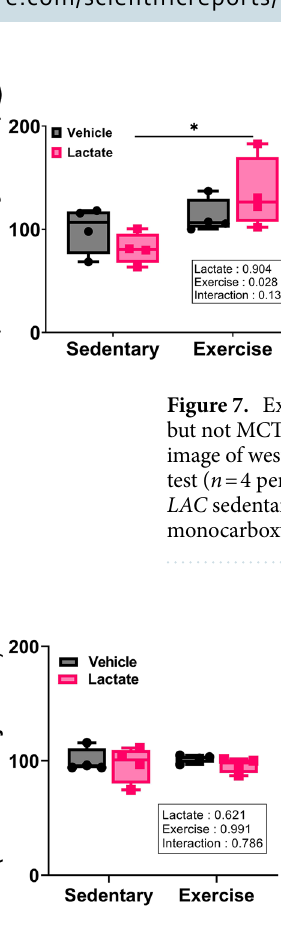
Figure 8. Exercise, lactate, and co-treatment did not affect hippocampal VEGFA and HCAR1 protein expression. Level of protein expression of hippocampal ( A ) VEGFA and ( B ) HCAR1. ( C ) The represent image of western blot. Two-way ANOVA was performed, and independent Student’s t -test was used for post hoc test ( n = 4 per group). The original blots are presented in Supplementary Figs. 4 and 5. VEH sedentary without lactate, LAC sedentary with lactate, EXE + VEH exercise without lactate, EXE + LAC exercise with lactate, VEFGA vascular endothelial growth factor A, HCAR1 hydroxycarboxylic acid receptor 1. Data are presented as box